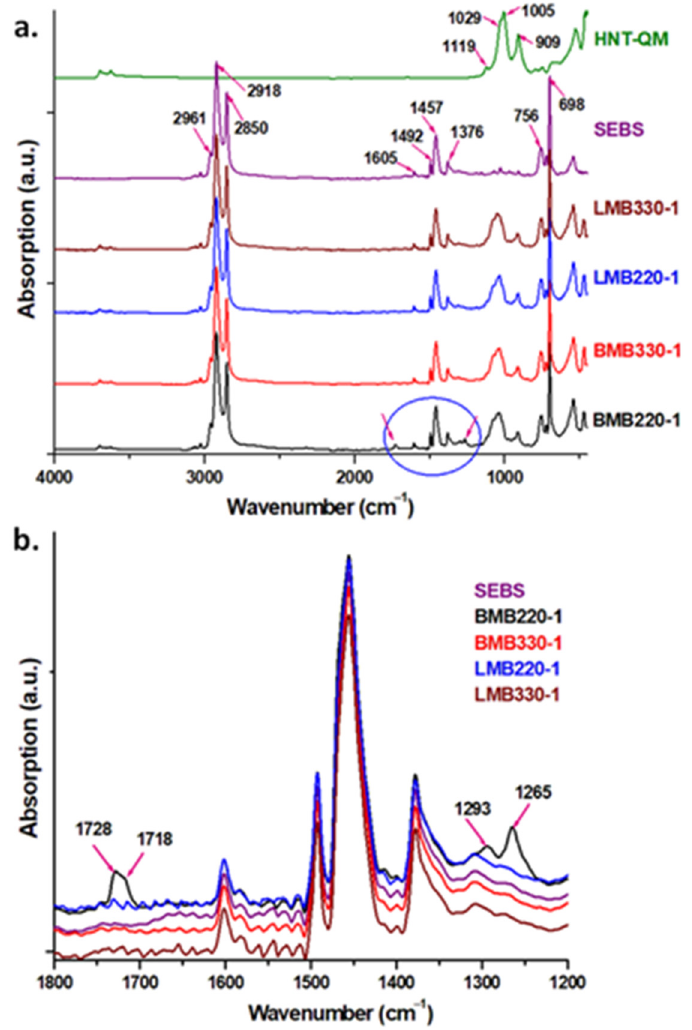
Figure 3. FTIR spectra for HNT-QM, SEBS and masterbatches obtained with the low temperature profile during extrusion: ( a ) full range and ( b ) narrow range 1800–1200 cm − 1 .